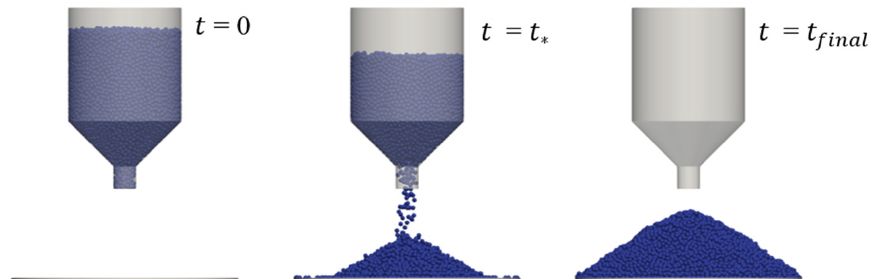
Figure 5. Simulation of angle of repose for sandpile. Table 5. Angle of repose for various friction coefficients.